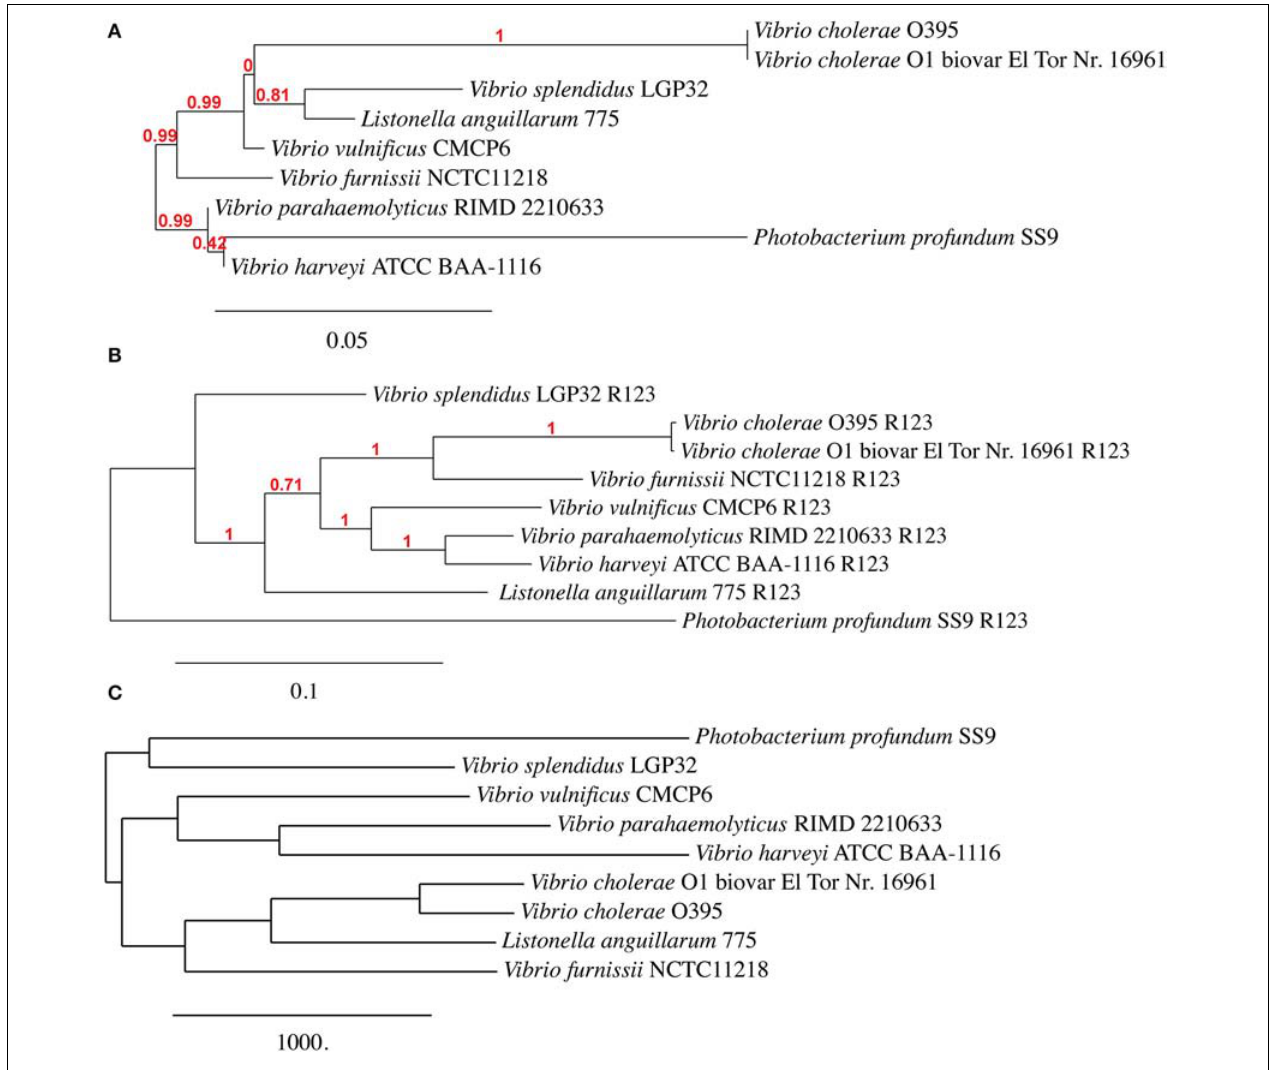
FIGURE 2 | Phylogenetic trees based on (A) 16S rRNA, (B) from concatenated nucleotide sequences from regions R1, R2 and R3 and (C) based on Vibrio pangenome from V. furnissii NCTC 11218, V. cholerae